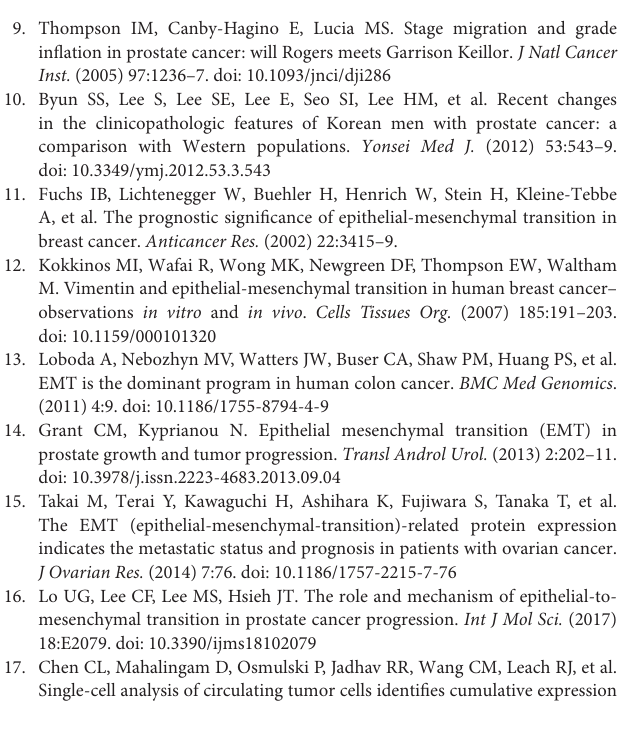
Supplementary Table 1 | Gleason group distribution among the EMT score categories. Supplementary Table 2 | Regression coefficients of the multiple regression model. Supplementary Figure 1 | Mean plot of mean EMT score in percentage vs. different Gleason groups showing a linear association. Linear association exists between mean EMT score and the assigned Gleason groups A; Gleason scores 6 and 7(3 + 4), group B; Gleason score 7(4 + 3), and group C; Gleason scores 8 and 9, where the mean percentage EMT score increases drastically when the gleason group increases. Supplementary Figure 2 | Scatterplot of the EMT score vs. different Gleason groups showing a linear association. A Mantel–Haenszel test of trend was run to determine whether a linear association existed between EMT score categorized into two groups ( < 25 and ≥ 25%) and the assigned Gleason groups revealing a statistically significant linear association between them ( Supplementary Table 1 , p < 0.007), where higher Gleason group was associated with a higher EMT